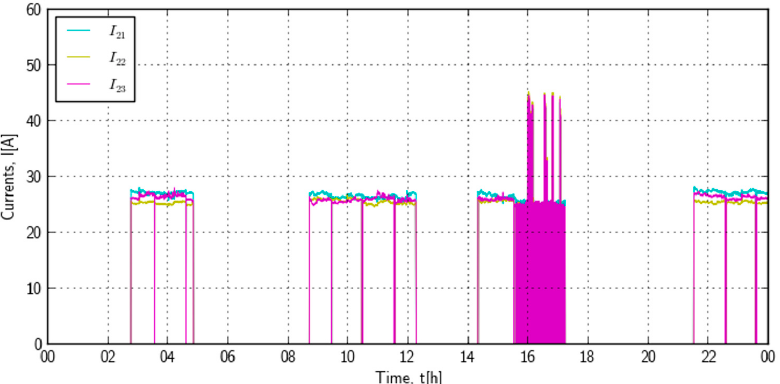
Figure 18. The diagrams of the load current changes of PU2 recorded on 21 June 2009.